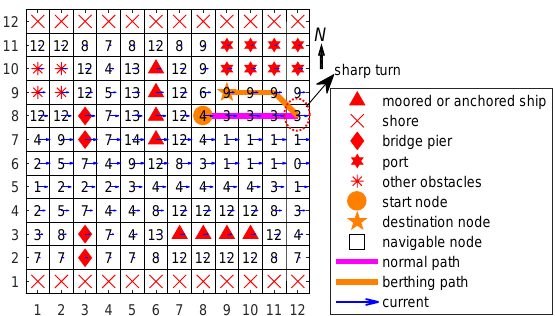
Figure 6. The combined path with a sharp turn